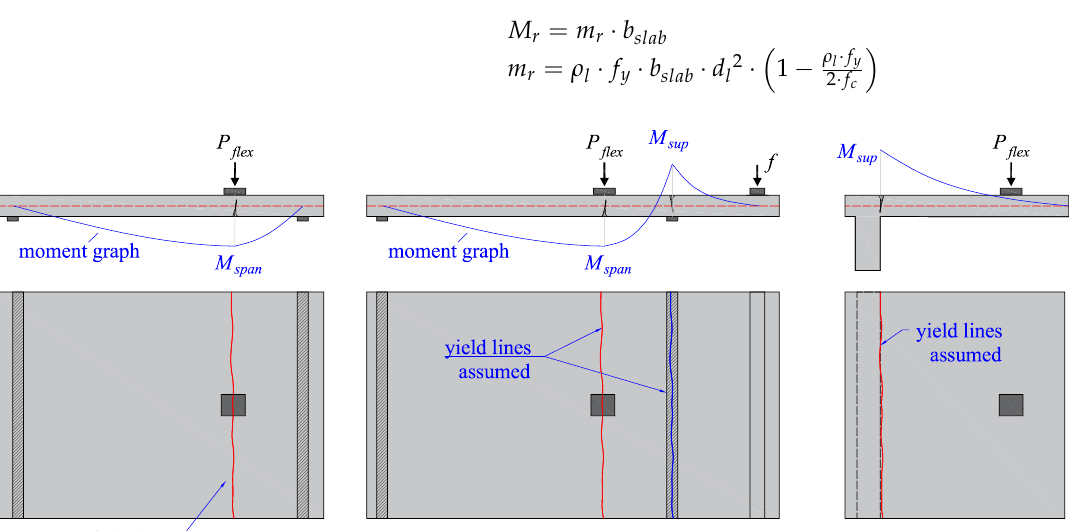
Figure 9. Yield line pattern for flexural assessment of simply supported, continuous and cantilever slabs.